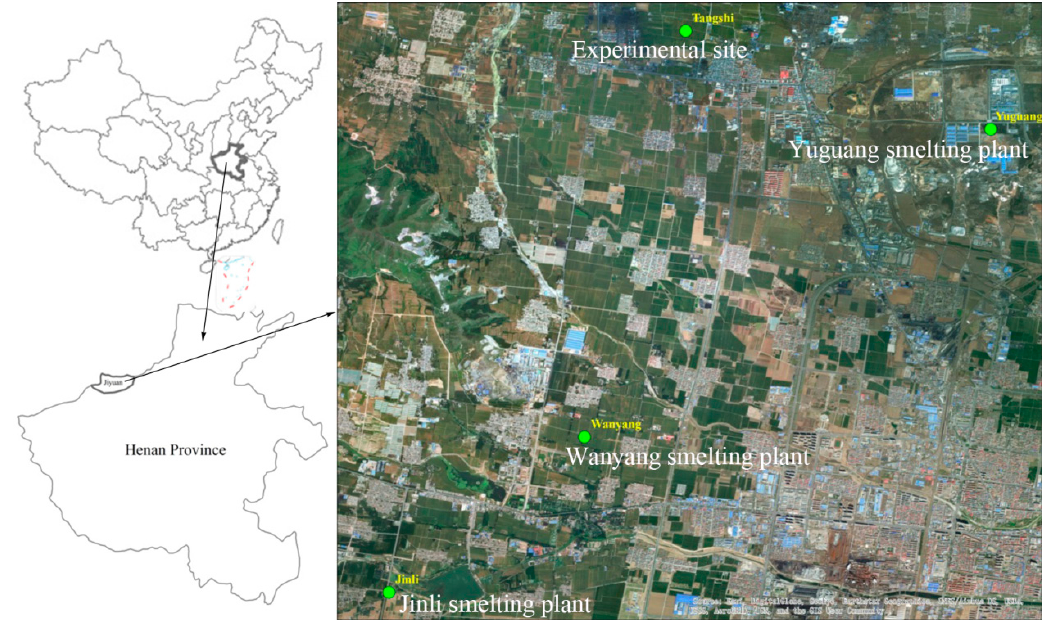
Figure 1. The location of the experimental site and smelting plants.